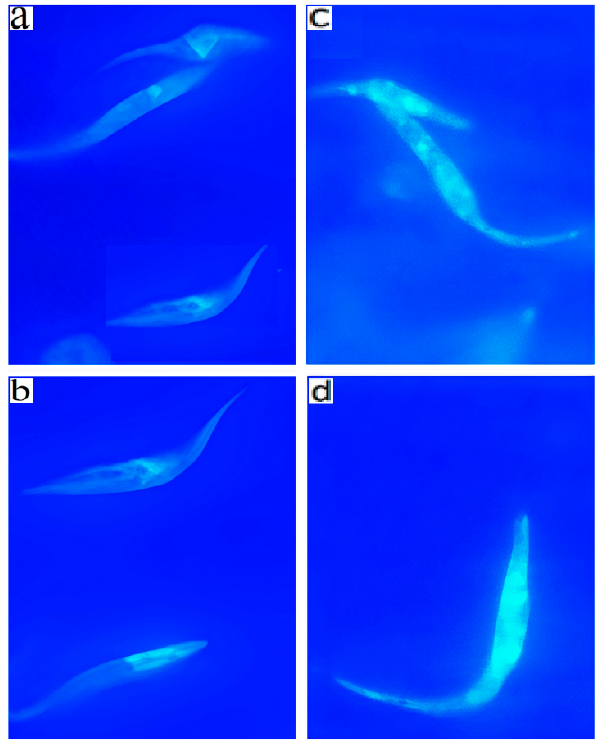
cells (Annexin V positive/PI negative), upper-right quadrant represents late apoptotic cells (An-